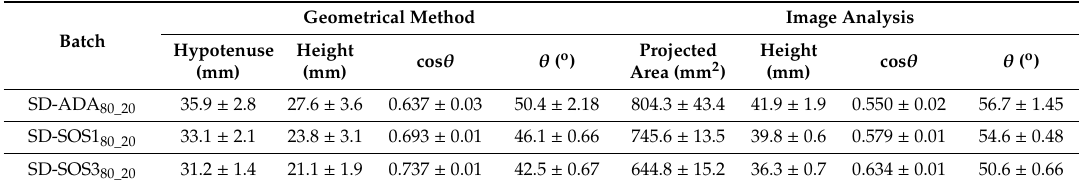
Figure 8. Statistical interaction plots of the effects of starch type and microencapsulating wall on: ( a ) particle shape, ( b ) tapped density, ( c ) angle of internal flow (Varthalis–Pilpel equation), and ( d ) constant T (Mohammadi–Harnby equation). On the x-axis, 1 represents a polysaccharide wall (PSC) and 2 represents a polymer / polysaccharide wall (PLM / PSC 80 / 20). Brown lines represent ADA, blue lines represent SOS1, and green lines represent SOS3 starch grades. Table 5. Angle of repose calculated by two methods: (a) cone geometry and (b) mean projected area obtained by image